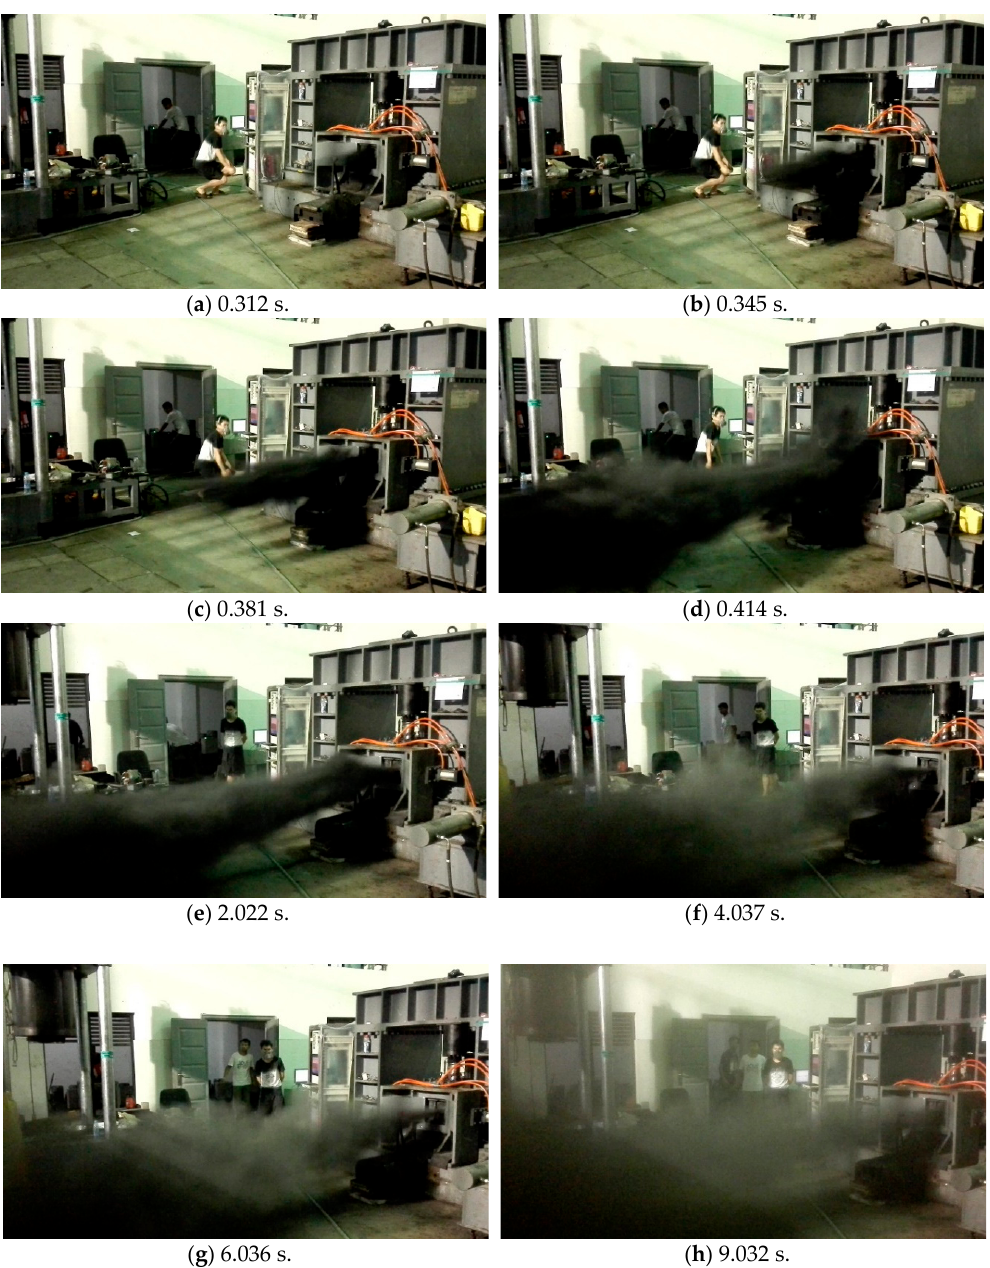
Figure 6. Pictures of the outburst observed at different times.